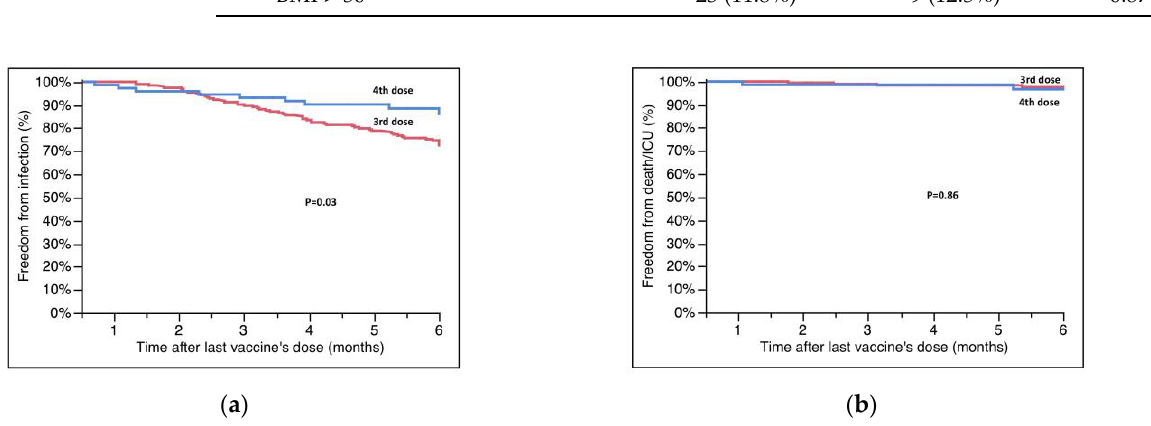
Figure 1. ( a ) Survival free from SARS-CoV-2 infection at six months according to the number of vaccine doses. ( b ) Survival free from ICU hospitalization/death according to the number of vaccine doses. Survival rates are reported in the text.